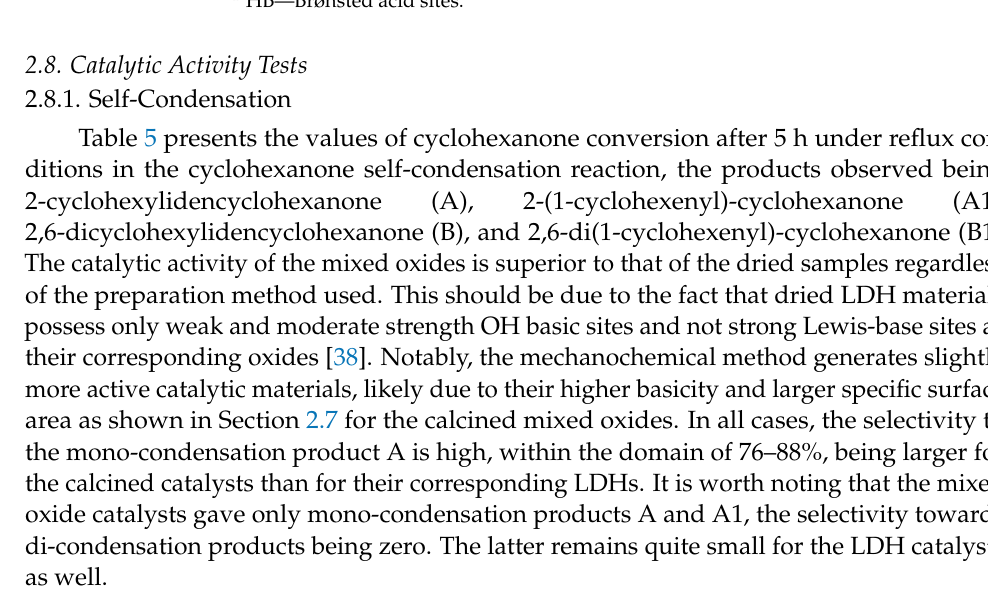
Table 5. Conversion (Conv.) and selectivity (Sel.) obtained during the self-condensation reaction of cyclohexanone after 5 h under reflux